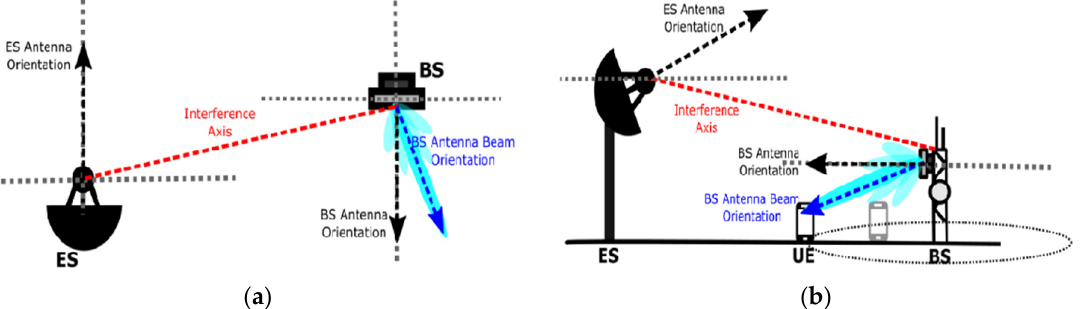
Figure 3. Carrier frequency set to the center frequency [7] in the ( a ) azimuthal and ( b ) elevation planes. From the FSS earth station to 5G base station.